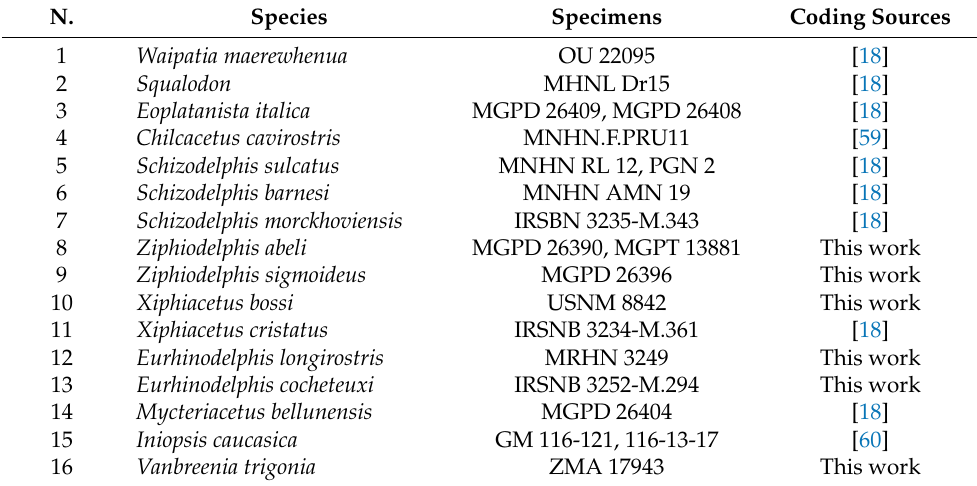
Table A3. Specimens coded for phylogenetic analysis and coding